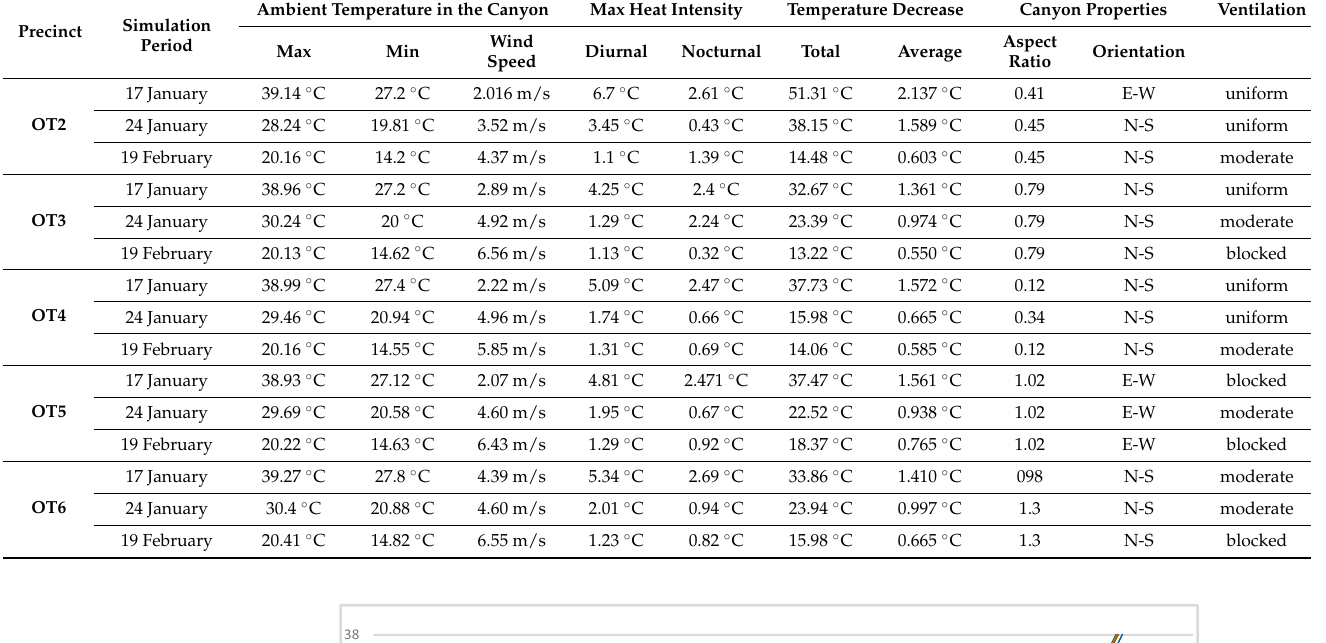
Table 11. Summary of main climatological variables during the simulation period in open-type arrangements.